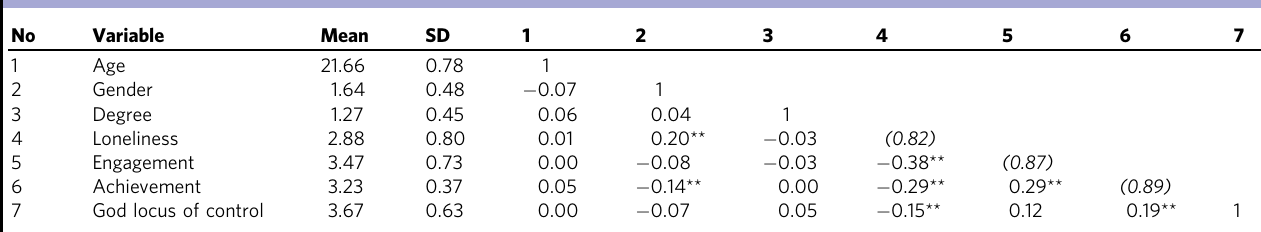
Table 3 Mean, SD, correlation and discriminant validity.